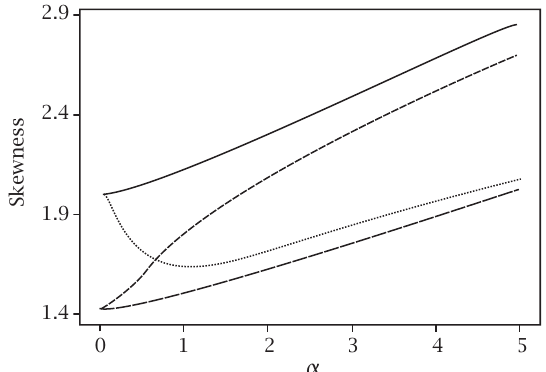
Figure 3.2 . The coefficient of skewness of the HGNB (α,a,p) distribution when (a,p) ≡ ( 1 , 1 ) ( − ) , ( 1 , 2 ) ( ··· ) , ( 2 , 1 ) ( −−− ) , ( 2 , 2 ) ( − . − ) .